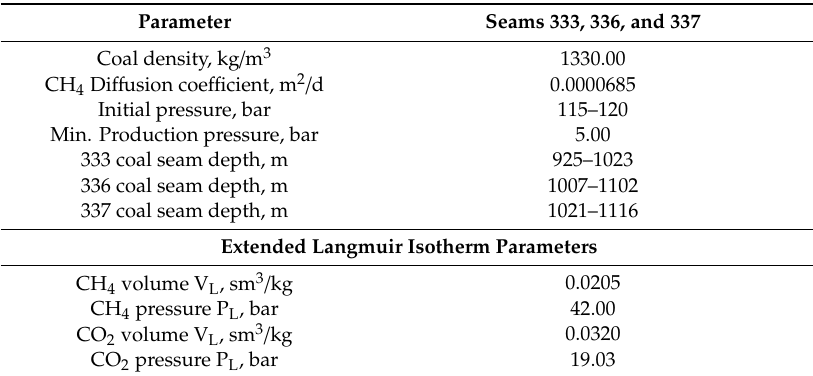
Table 4. Parameters used for modeling the CBM